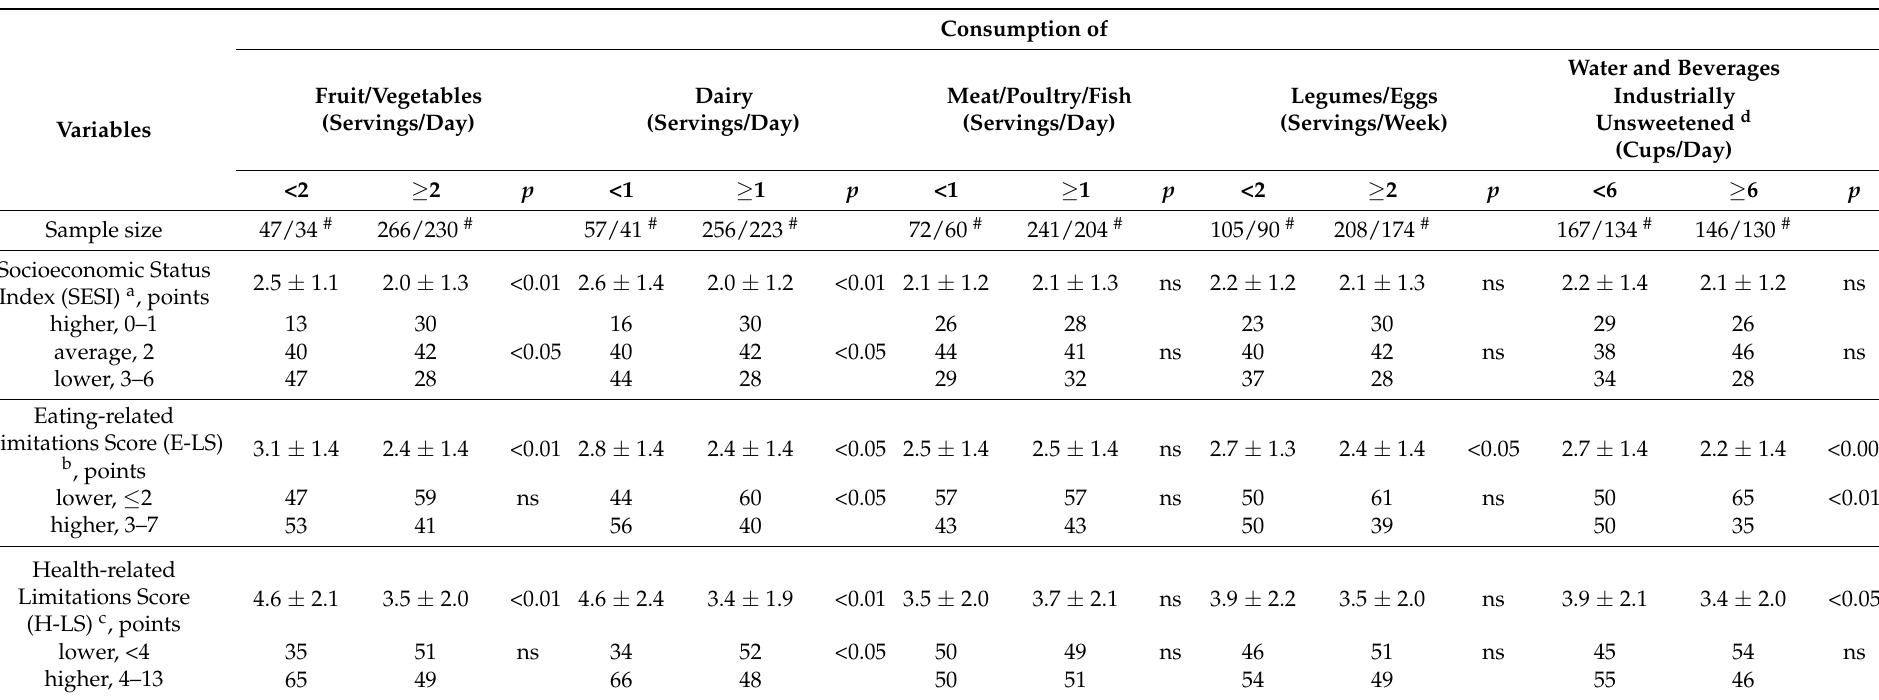
Table 5. The socioeconomic, eating, and health-related limitations scores of food consumption among Polish women 60+ years (% of the sample or mean ±